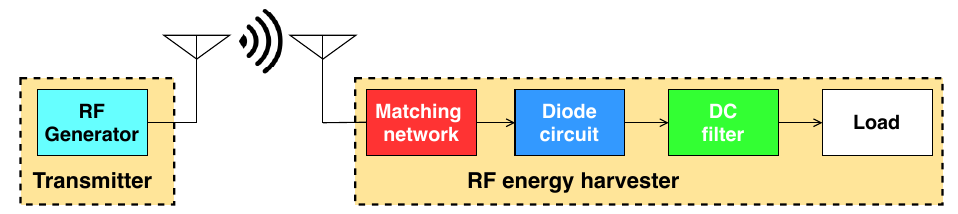
Figure 2. Block structure of the RF energy harvester.